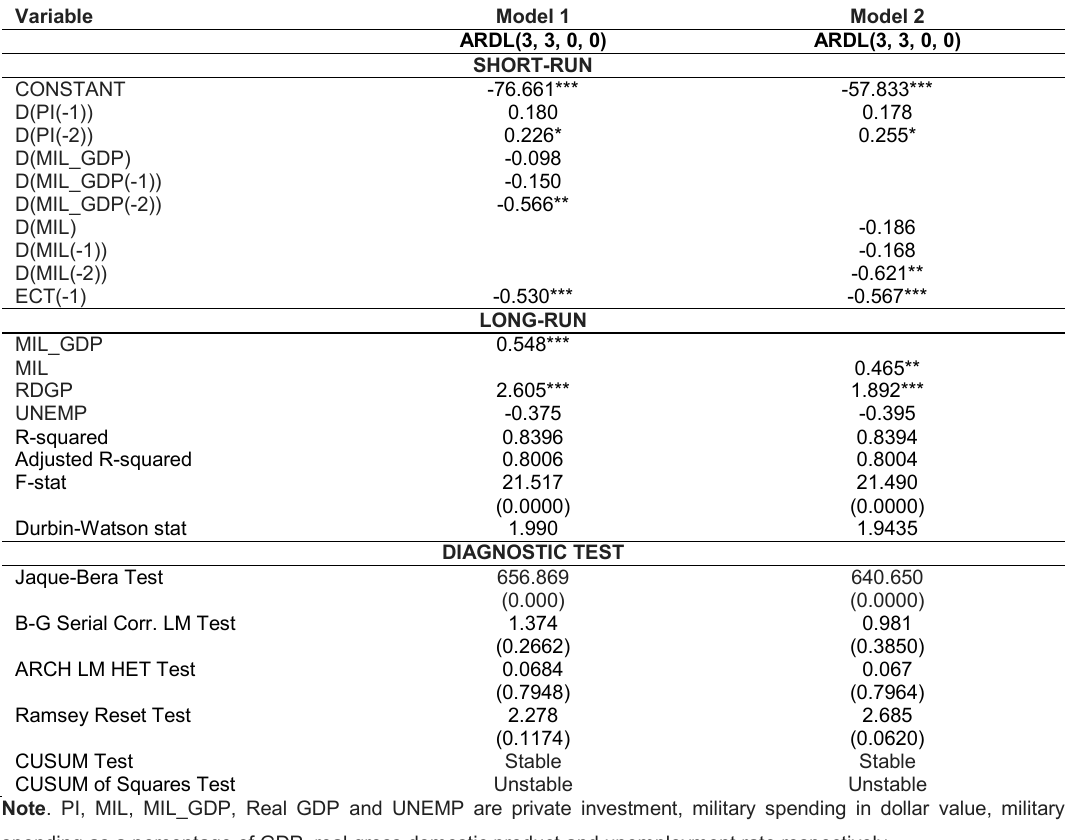
Table 6. ARDL results: effect of military spending on private